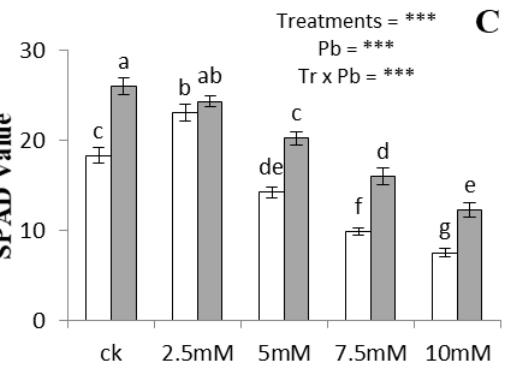
Figure 3. E ff ect of Pb and acetic acid on soluble proteins in roots ( A ), soluble proteins in leaves ( B ) and SPAD value ( C ) of Alternanthera bettzickiana grown in soil with increasing Pb concentrations (0, 2.5, 5, 7.5 and 10 mM) and AA (0 and 2.5 mM). Values are mean of three replicates ± S.D. Di ff erent lowercase letters indicate significant di ff erences between treatments at p < 0.05; and *** indicate significance at the p < 0.01 level.